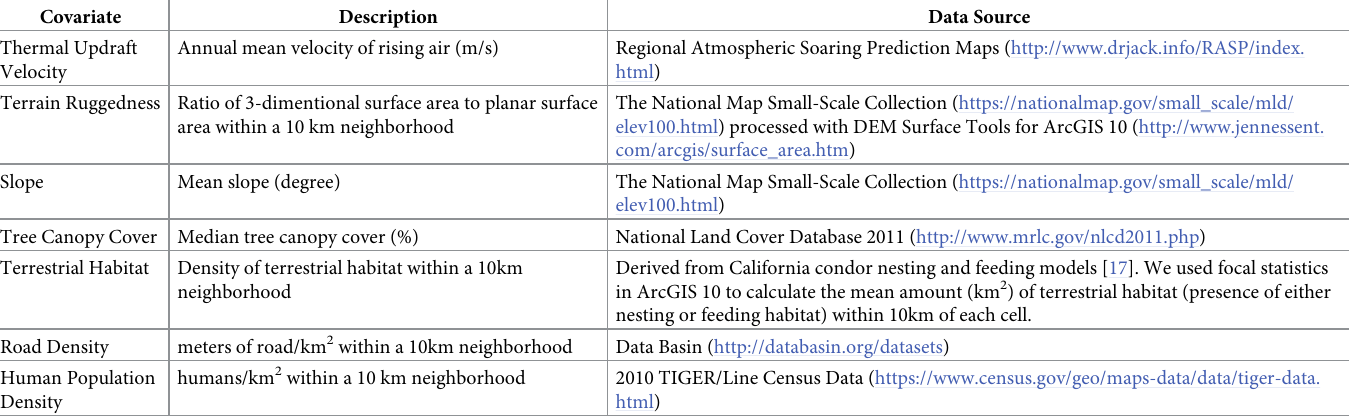
Table 1. Covariates used in developing a California condor landscape conductance surface. Covariate